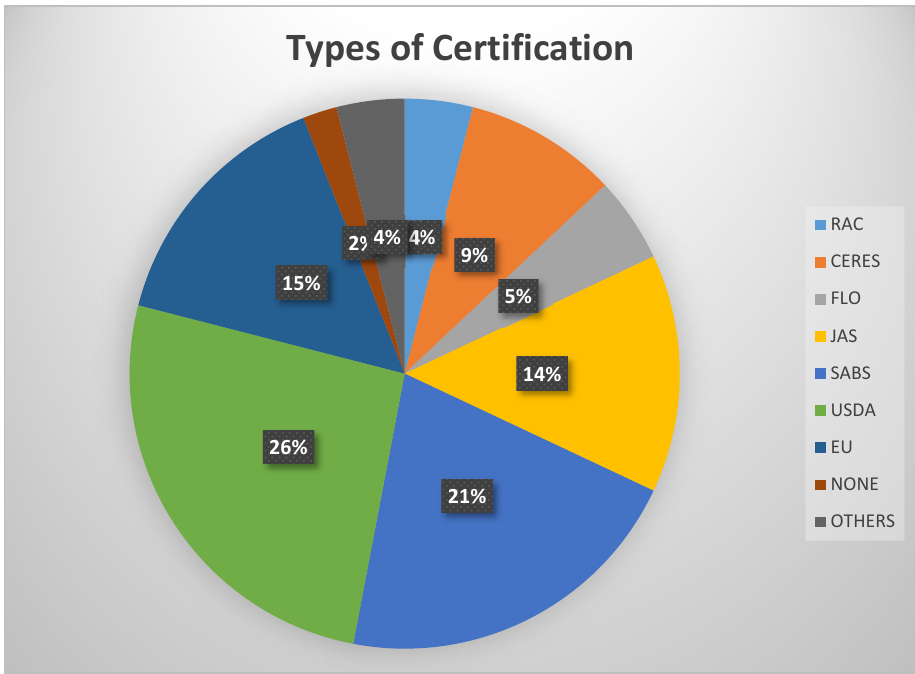
Figure 4. The rooibos tea farmers use different types of certifications. (RAC: Rainforest Alliance Certification; CERES: Sustainable Agricultural Networks; FLO: Flo fair trade labeling; JAS: Japanese Agricultural Standards; SABS: South Africa Bureau of Standards; USDA: United States Department of Agriculture; EU: European Union; NONE: No